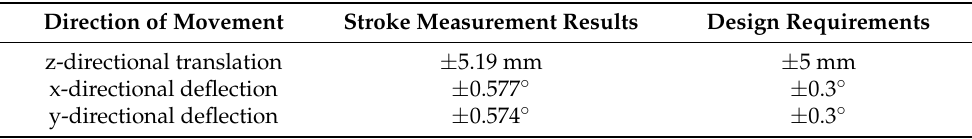
Table 2. Results of the actual working space measurement of the SMAM. Direction of Movement Stroke Measurement Results Design Requirements z-directional